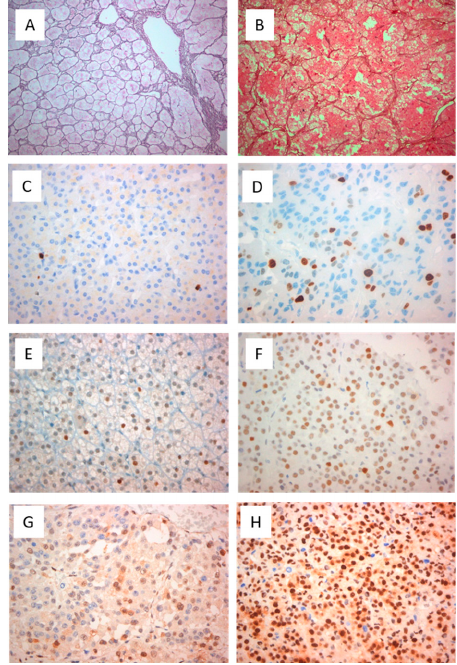
Figure 1. Histochemical and immunohistochemical expression of reticulin, Ki-67%, p53 and p27 in adrenocortical neoplasms. Intact reticulin framework with the characteristic acinar pattern in adrenocortical adenoma (ACA) ( × 200) ( A ). Highly disrupted architecture and loss of the reticulin framework in adrenocortical carcinoma ( ACC )(×400) ( B ). Increase of positive (brown stained) nuclei in Ki-67 immunostaining in ACA ( C ) compared to ACC ( D ). Strong nuclear expression (brown stained nuclei) of p53 protein in a few tumor cells in ACA (wild type pattern) (×400) ( E ), Strong nuclear expression of p53 protein in >80% of tumor cells in ACC (overexpression) (×400) ( F ). Moderate nuclear staining of p27 protein in ACA (×400) ( G ). Strong nuclear staining of p27 protein in the majority of cells in ACC (×400) ( H ).